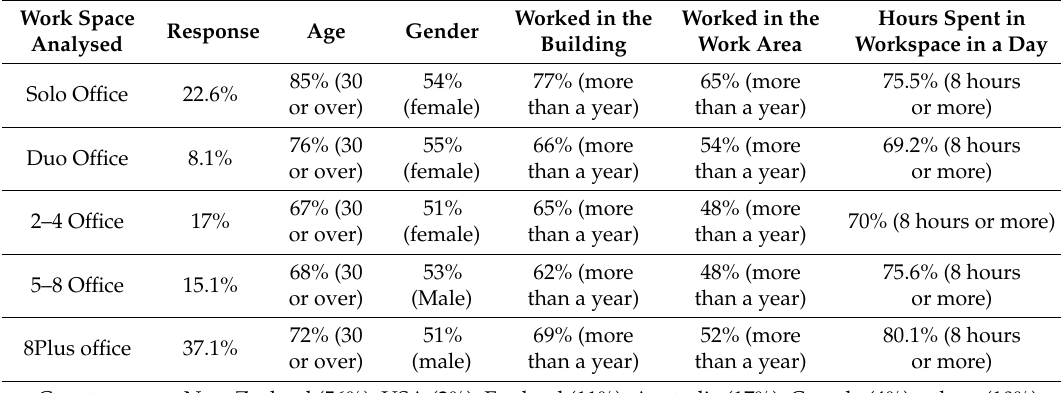
Table 1. Occupants’